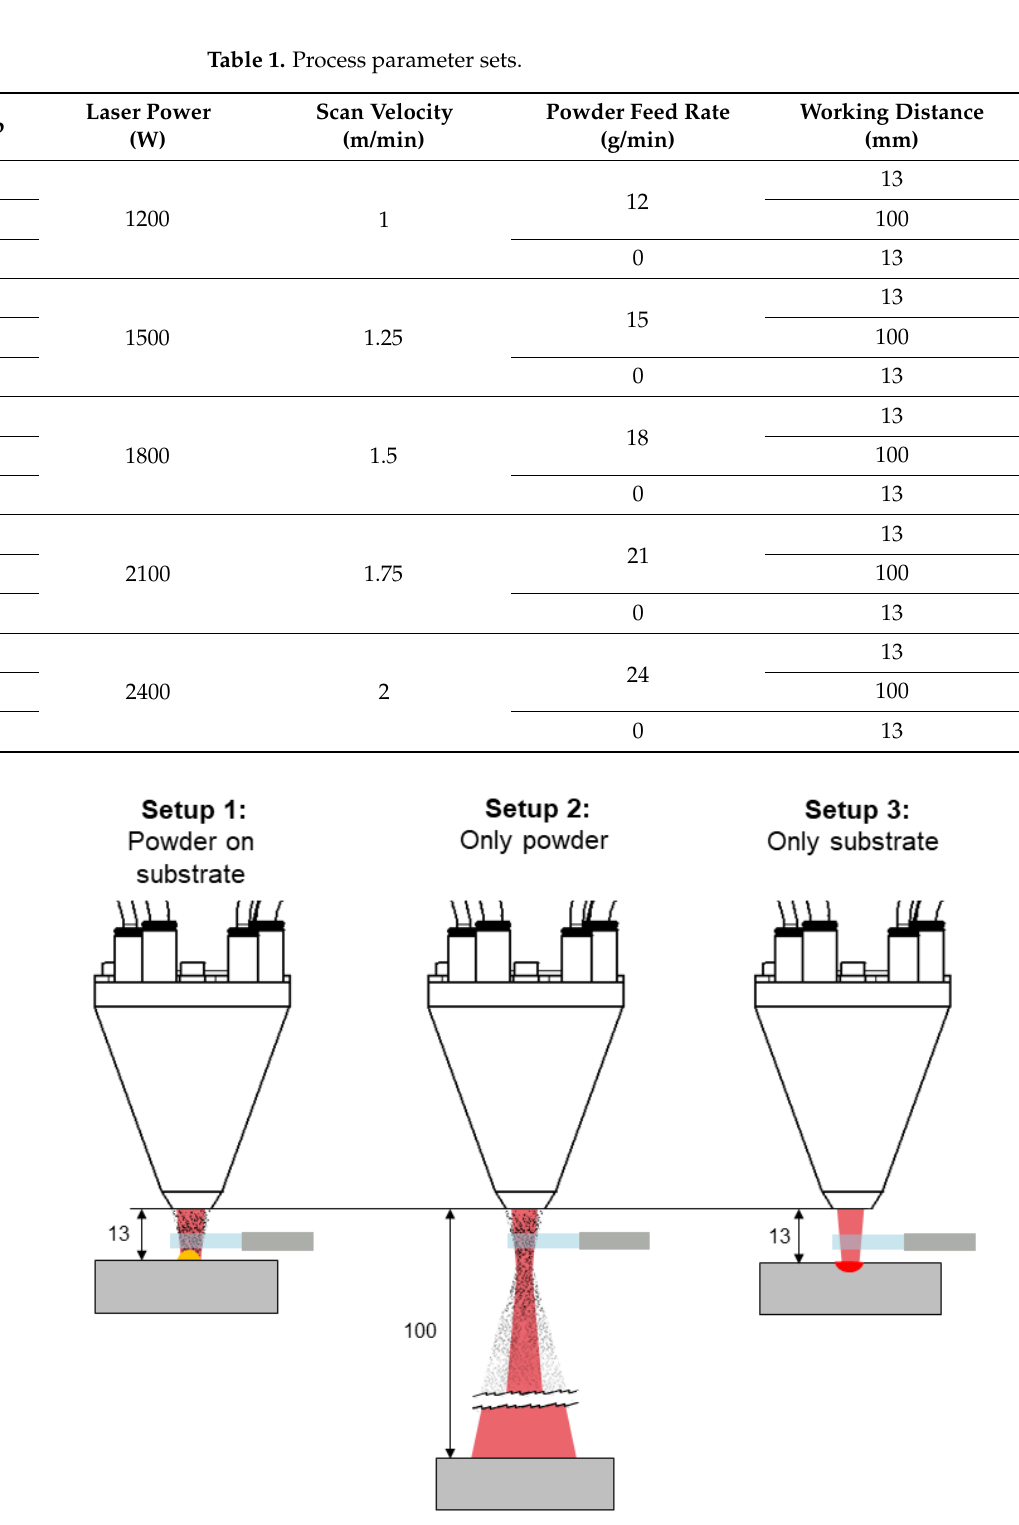
Figure 3. Experimental setups investigated in the present work. Table 1. Process parameter sets.